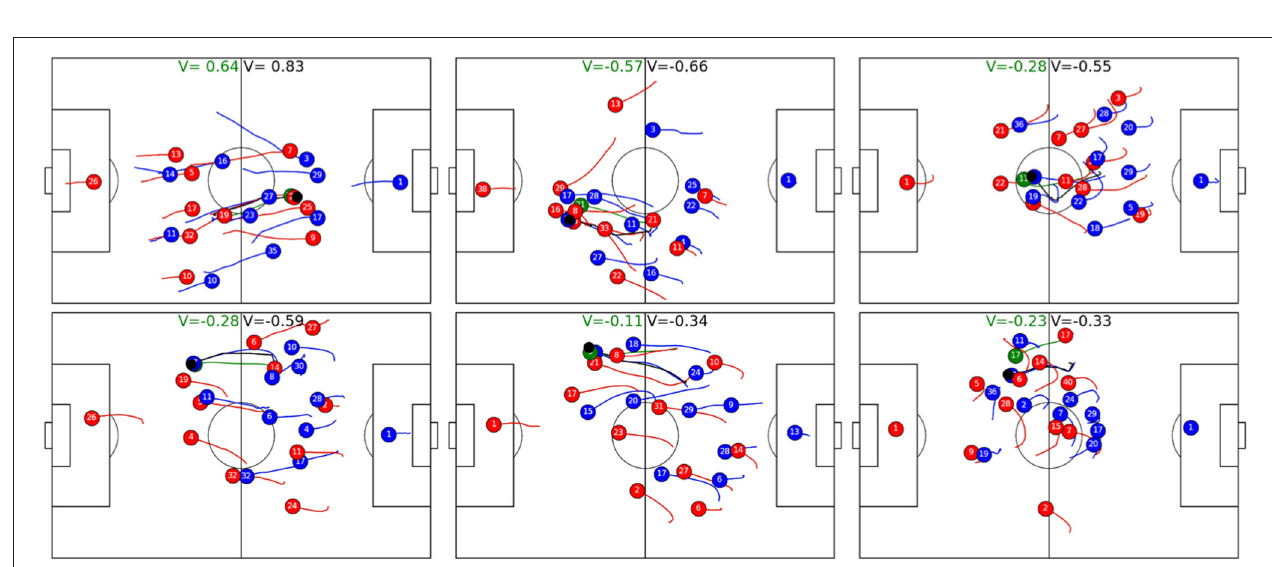
FIGURE 8 | Temporal development of the V for observed trajectories (Top) and when one player (10, blue) is simulated (Bottom) .